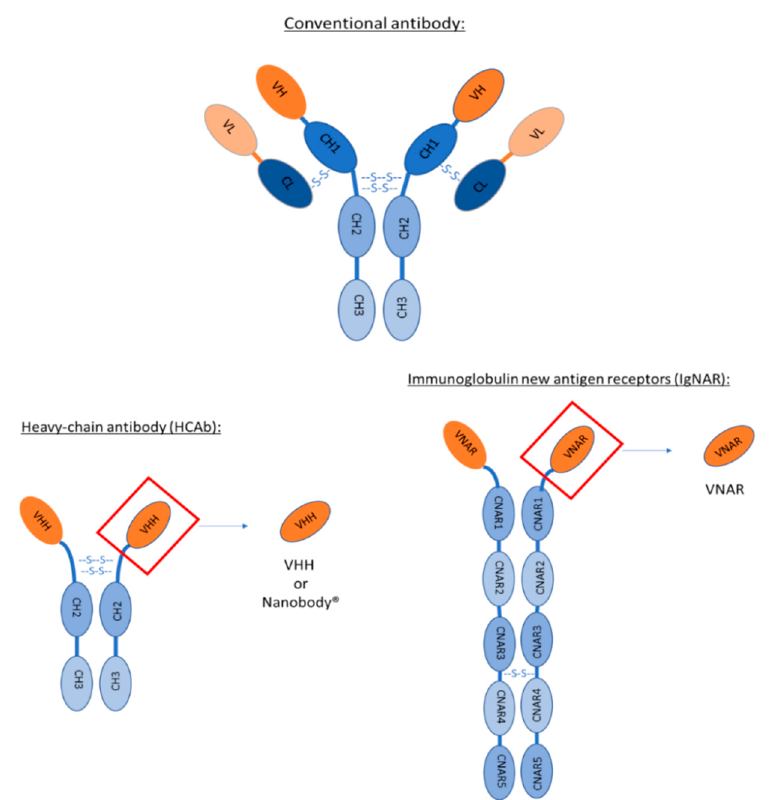
Figure 1. Schematic representation of conventional antibody versus heavy-chain antibody found in Camelidae versus immunoglobulin new antigen receptor found in sharks. VHH is the variable domain of heavy-chain IgG2 and IgG3. The difference between these two IgG is the length of the hinge (region between VHH and CH2). VNAR is the variable domain of IgNAR.